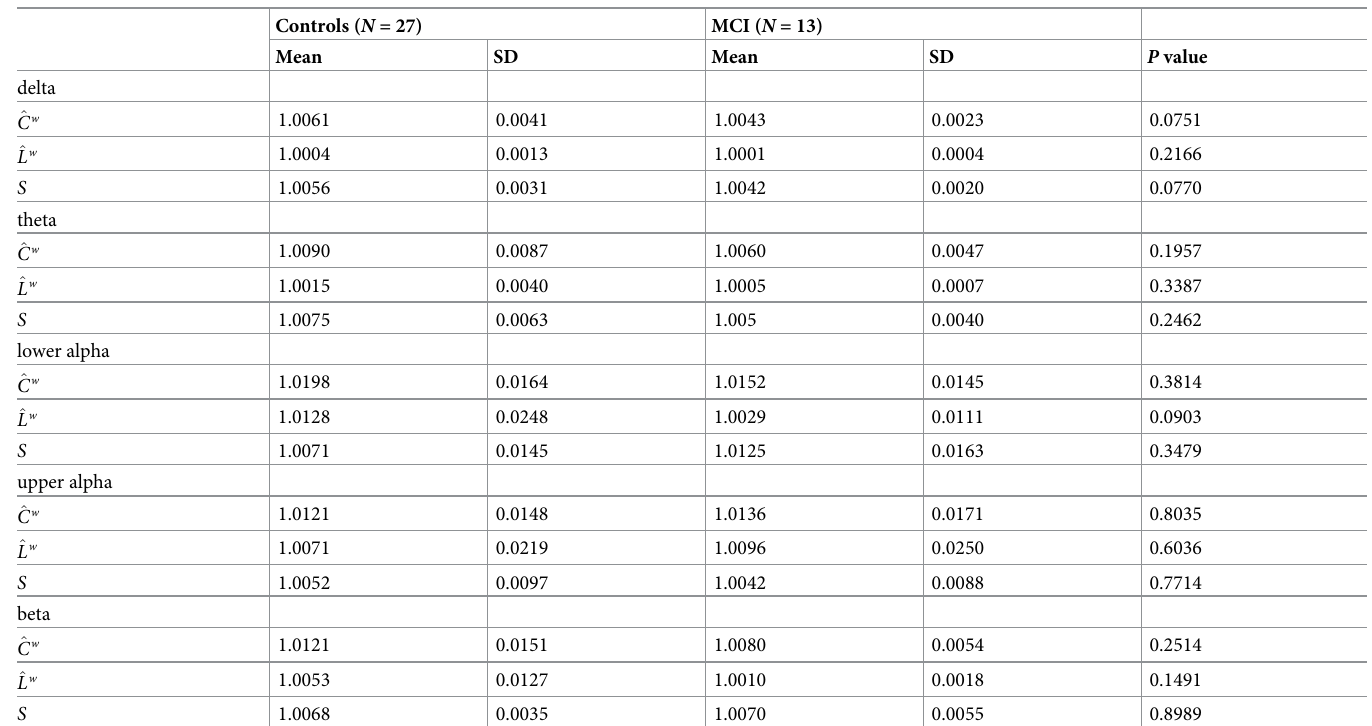
Table 4. Group descriptive for traditional measures.